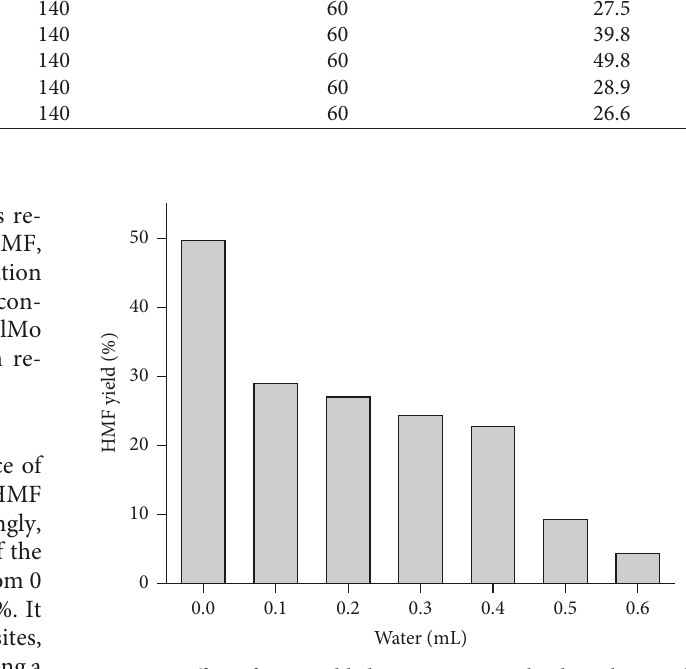
Table 2: Effect of catalyst weight on the acid-catalyzed dehydration of fructose to HMF a . No.